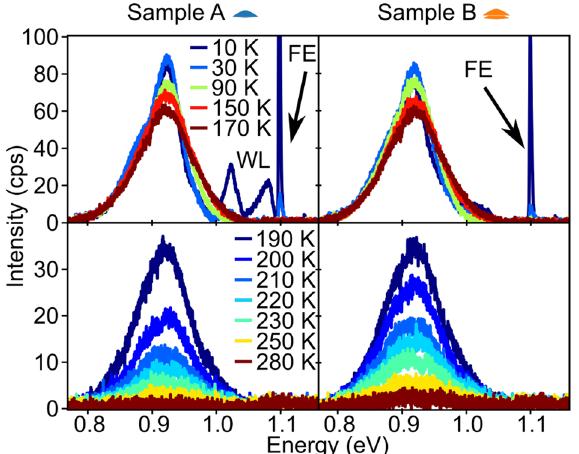
Figure 7. Temperature-dependent µ -PL measurements. Spectra shown in the left half of the figure are from the single-layer sample A, those in the right half from the stacked double-QD sample B with a Si spacer width of 2 nm. The temperature range from 10 to 170K is displayed in the upper panels, the range from 190 to 280K in the respective lower panels. Note the different span of the intensity scales of the upper and lower panels. The FE LO/TO signal from the Si substrate and the WL signal in sample A rapidly disappear with increasing temperature. While the intensities of the QD-related signal between 0.8 and 1.0 eV are comparable in both samples, the decay above 190 K is significantly more pronounced in the single-QD-sample